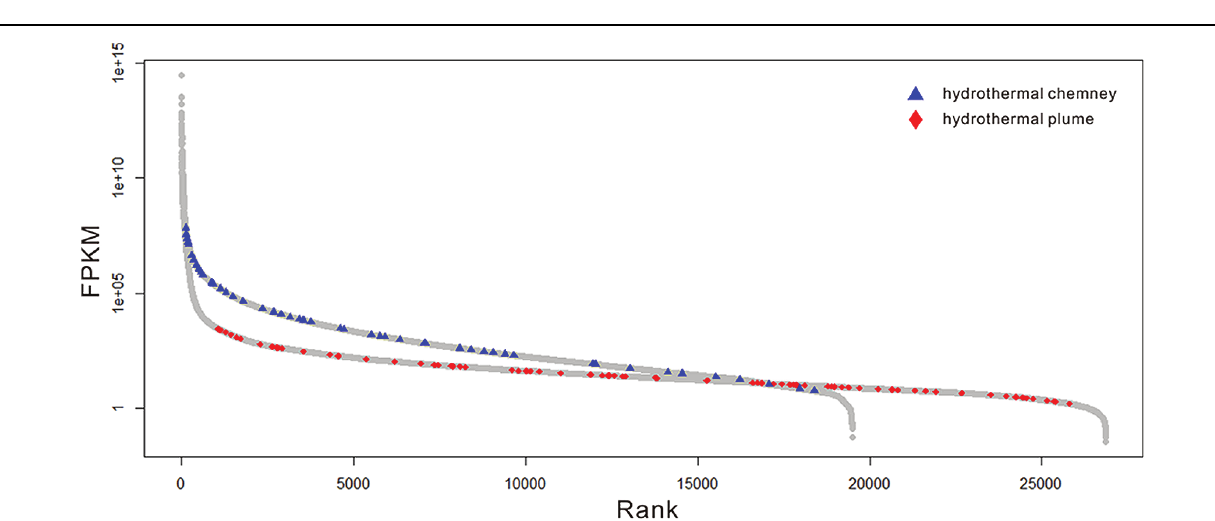
FIGURE 4 | Expression profiles of the genes in the metatranscriptome. The gray circles indicate the genes of the whole community. The blue triangles and red diamonds represent those related to sulfur oxidation and reduction in this metatranscriptome and a previous study (Lesniewski et al., 2012), respectively. The relative abundance of the gene transcripts was normalized to the length of the gene fragment and the total number of all of the